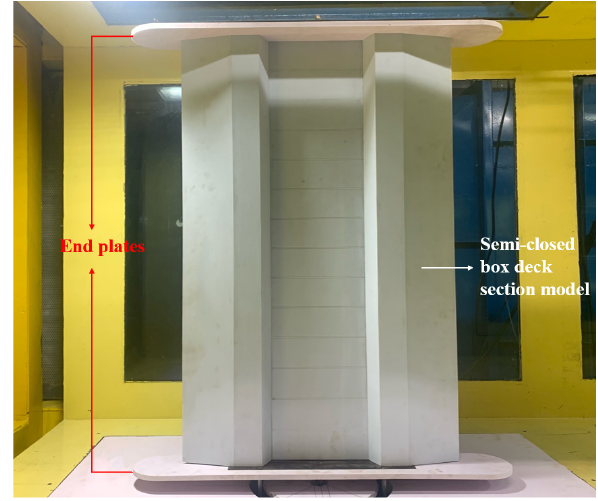
Figure 7. Test model in wind tunnel.